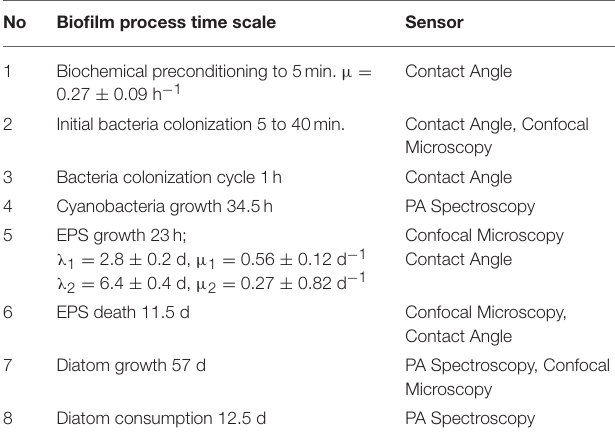
TABLE 2 | Characteristic time-dependent features of marine biofilm